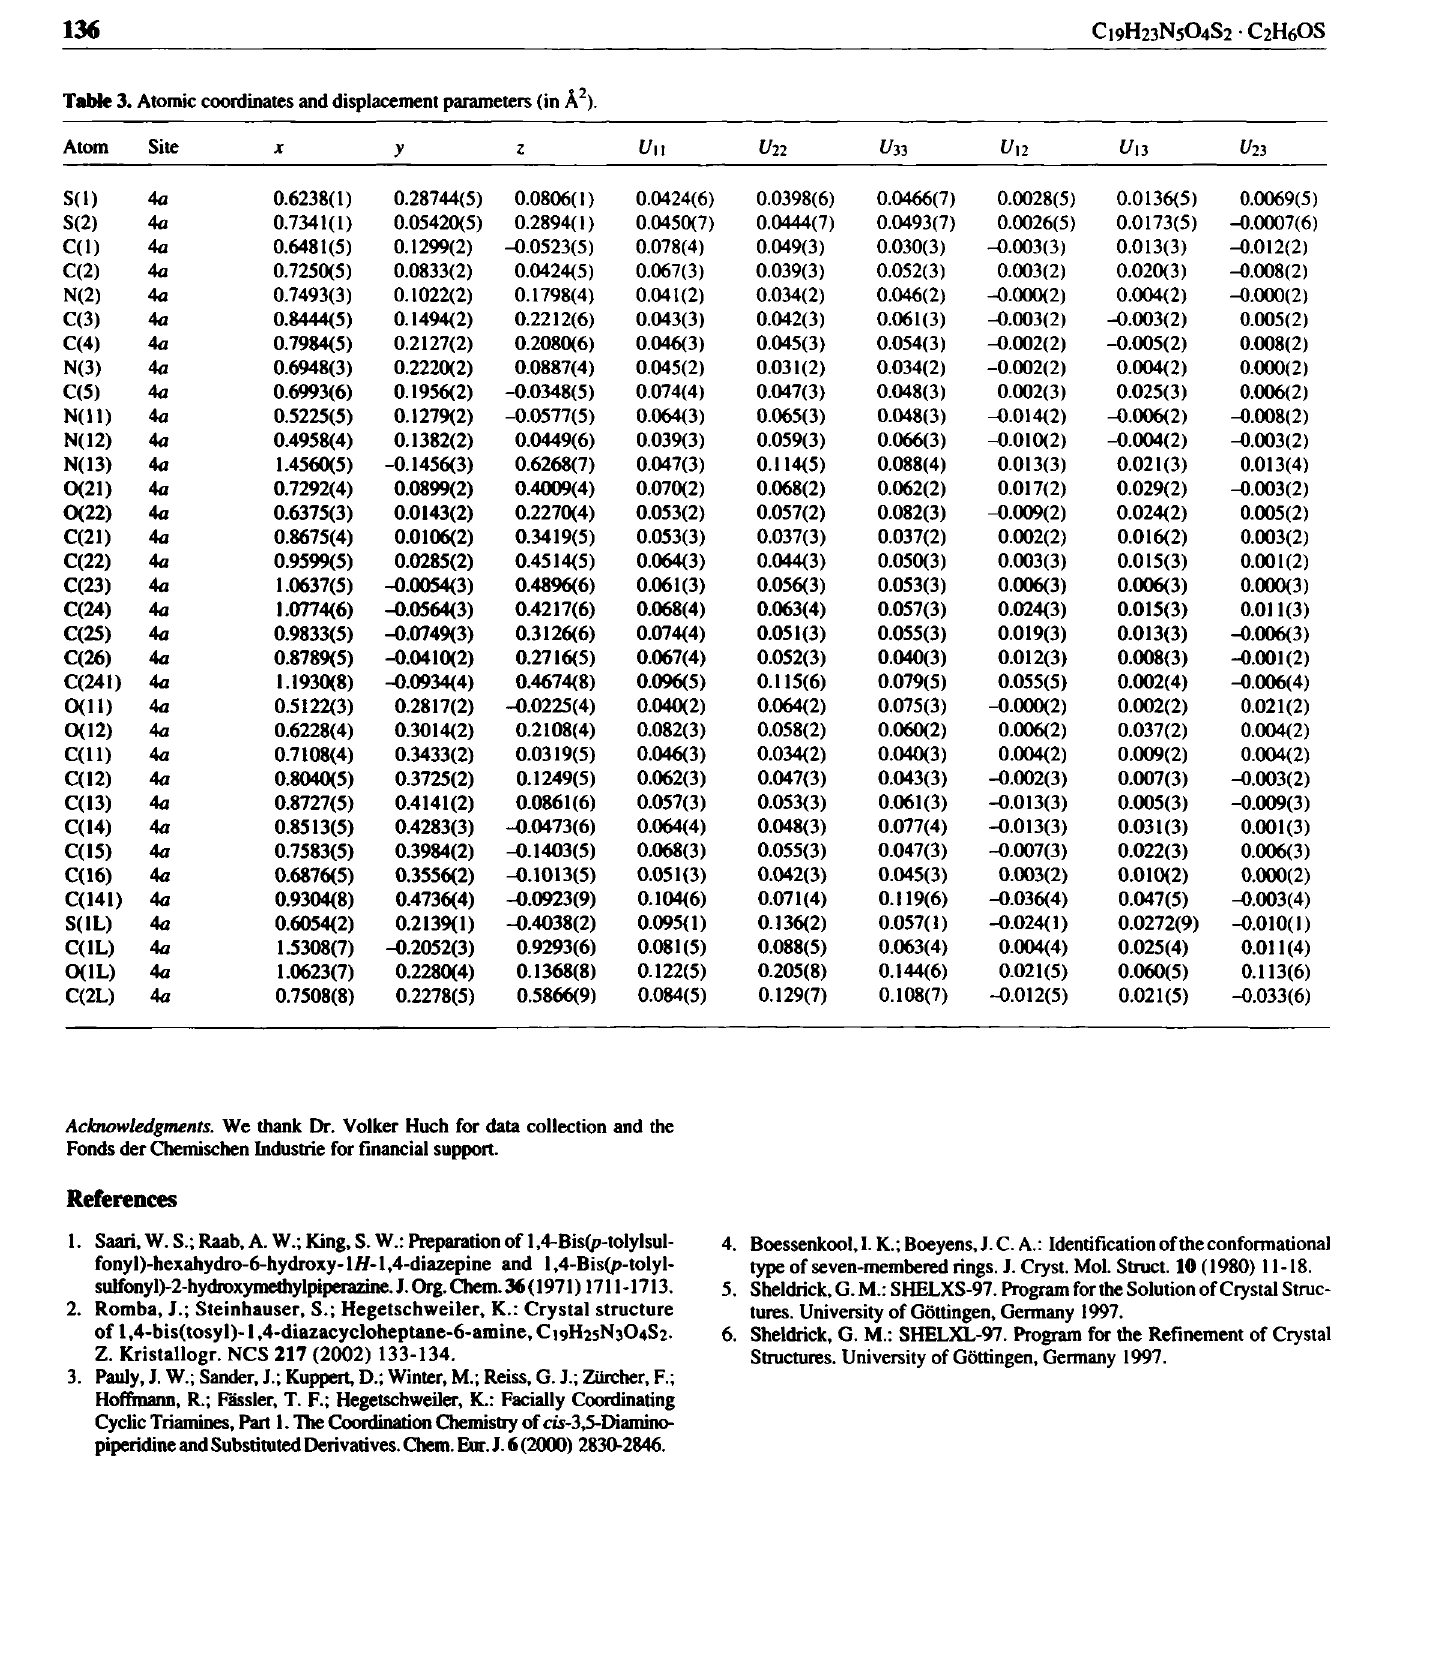
Table 3. Atomic coordinates and displacement parameters (in Â 2